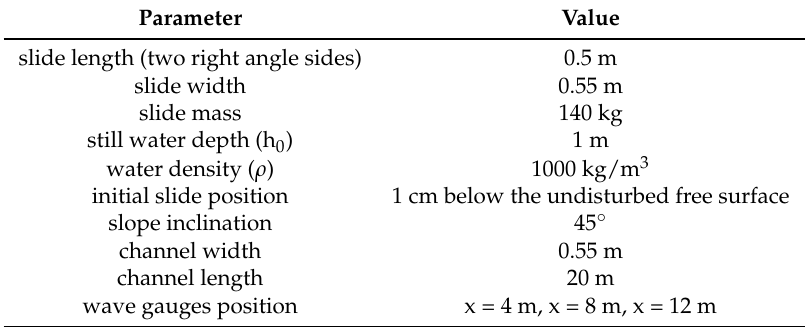
Table 1. Summary of important parameters in the Heinrich [7] experiment (Figure 1a).